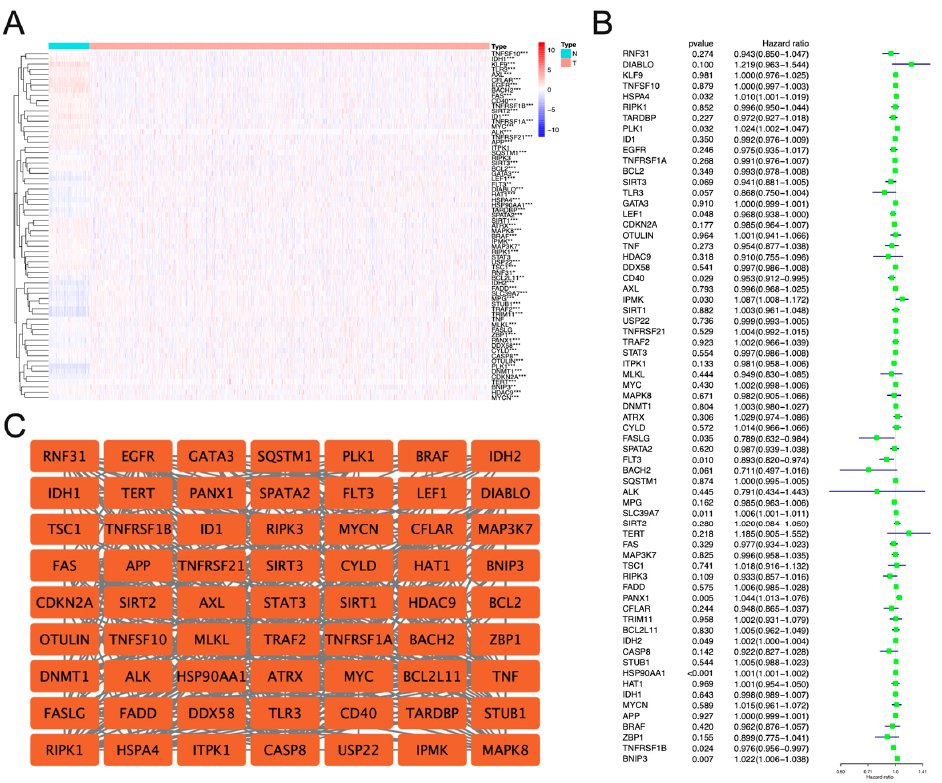
Figure 2. Expression and interaction of necroptosis-related molecules in BC. ( A ) Heat map showing the expression of target necroptosis-related genes in breast cancer. * p < 0.05, ** p < 0.01, and *** p < 0.001. ( B ) The forest plot shows the univariate Cox analysis of necroptosis-related genes in breast cancer. ( C ) This protein–protein interaction network shows how target necroptosis-related genes interact.